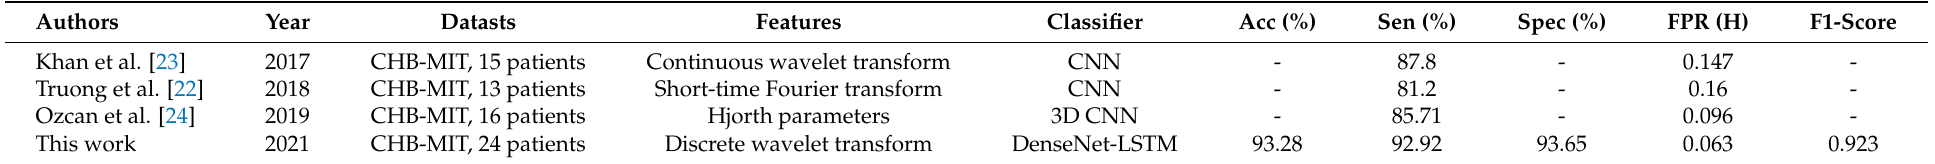
Table 6. Results of a recent epileptic seizure prediction approach on the CHB-MIT scalp EEG dataset. In the case of “This work”, the results of 5 min of preictal length, which had the best results, were